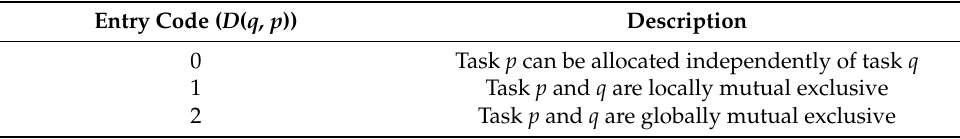
Table 9. Entry codes for dependency matrix in centralized TACTAR.